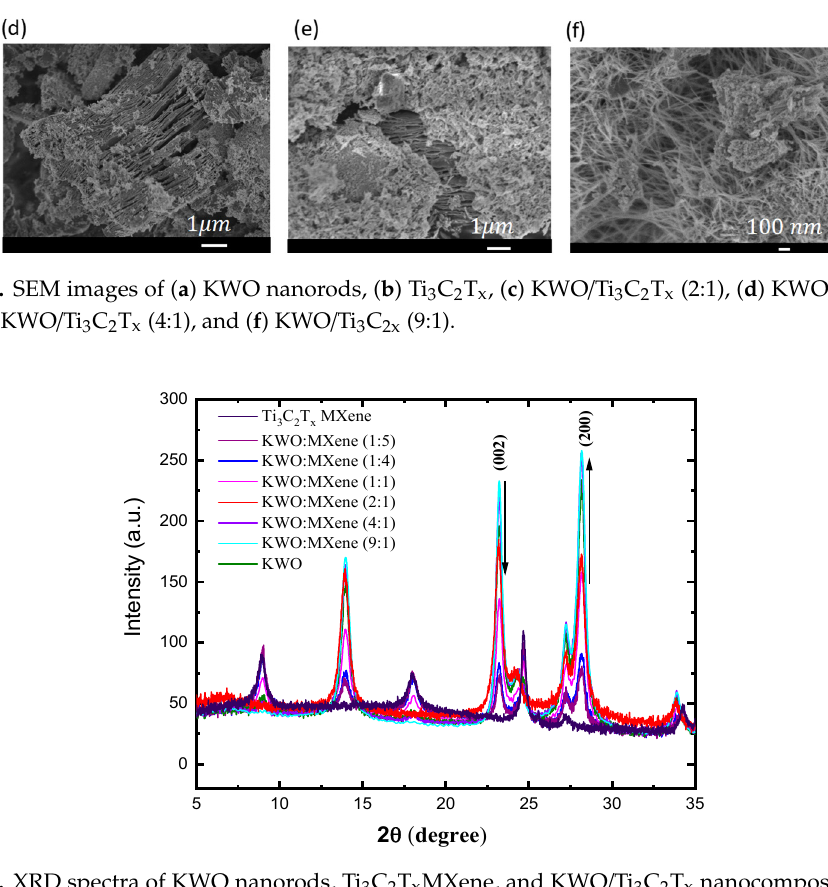
Figure 3. XRD spectra of KWO nanorods, Ti 3 C 2 T x MXene, and KWO/Ti 3 C 2 T x nanocomposites, and Ti 3 C 2 T x MXene.